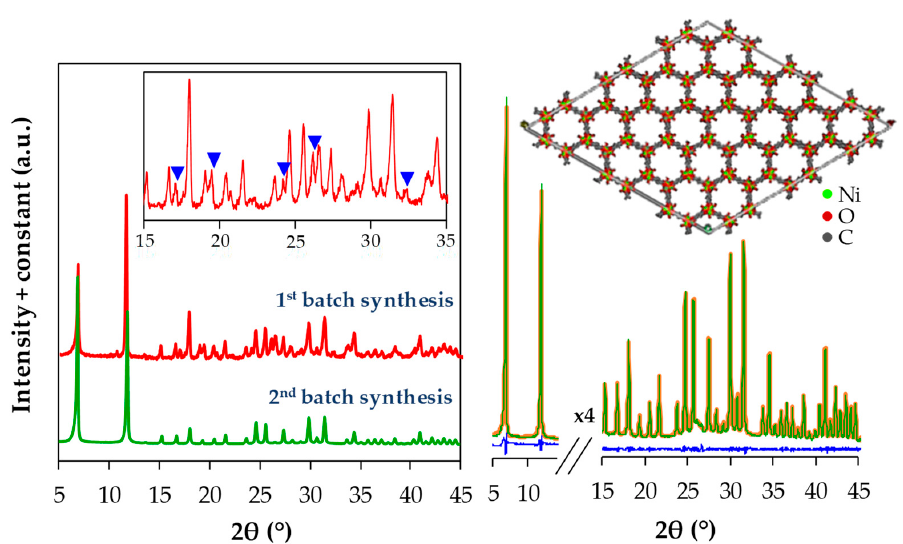
Figure 4. (left) Powder X-ray diffraction (PXRD) patterns of Ni-MOF-74 samples from the first-batch synthesis (red) and the second-batch synthesis with centrifugations 1 and 2 (green). (right) Results of Rietveld refinement on the second-batch sample; green, yellow, and blue lines represent experimental data, indexed reflections of molecular structure of Ni-MOF-74, and difference plot, respectively. Table 1. Crystallographic data of synthesized Ni-MOF-74.